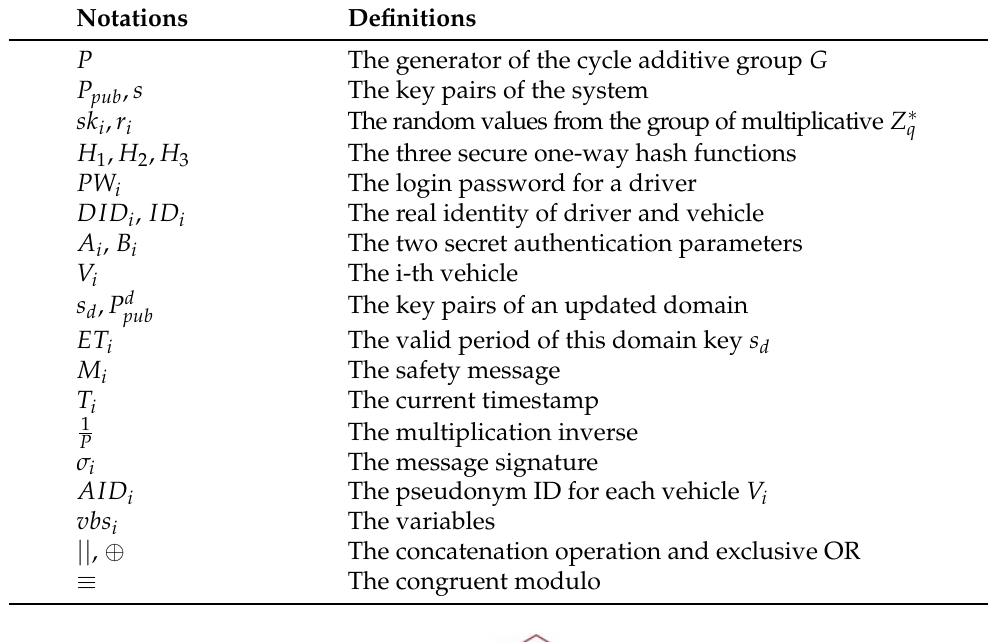
Table 1. Notations.